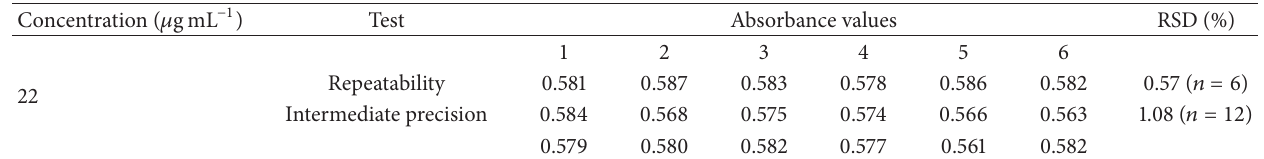
Table 3: Values determined for the parameter precision of rifaximin work standard by absorption spectrophotometric method in the ultraviolet region.